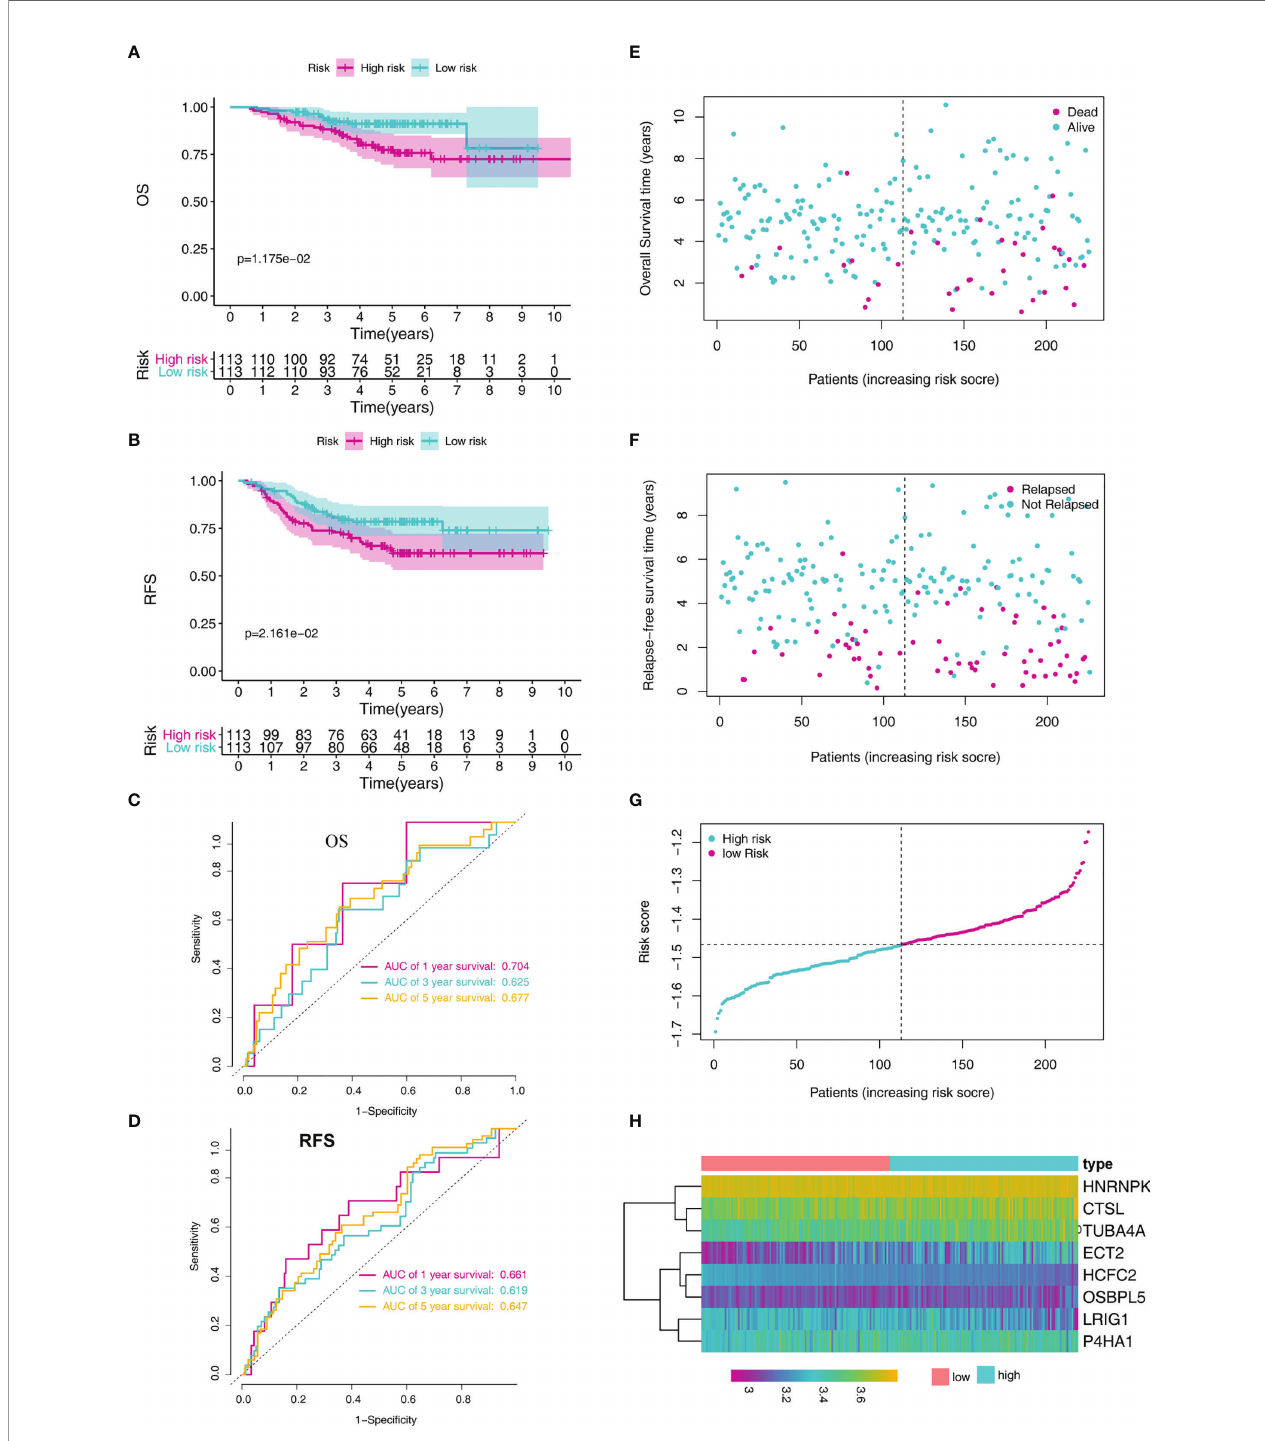
FIGURE 4 | MRG-based risk signature evaluation using the validation set (GSE31210). (A) Kaplan-Meier analysis of the overall survival in LADC patients based on risk strati fi cation. (B) Kaplan-Meier analysis for relapse-free survival of LADC patients based on risk strati fi cation. (C) Time-dependent ROC curve analysis for 1-, 3-, and 5-year overall survival predictions obtained using the MRG-based signature. (D) Time-dependent ROC curve analysis for 1-, 3-, and 5-year relapse-free predictions obtained using the MRG-based signature. (E) Overall survival scatter plots for LADC patients. (F) Relapse-free survival scatter plots for LADC patients. (G) Risk score distribution of the LADC patients. (H) The heatmap of the eight